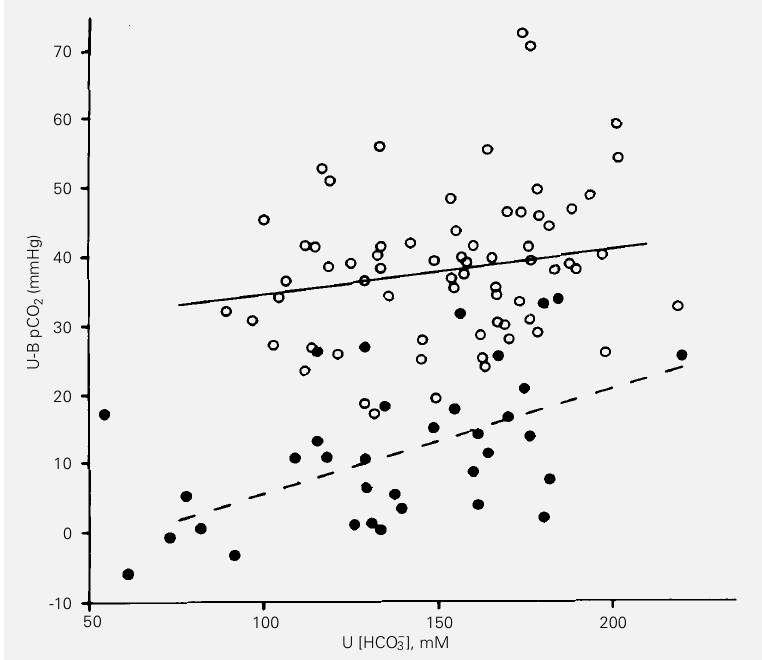
Figure 3 - Urine minus blood pCO 2 (U-B pCO 2 ) differences plotted against urine bicarbonate concentration (U) in control (open circles) and adrenalectomized (filled circles) rats. From Ref. 27, with permission.